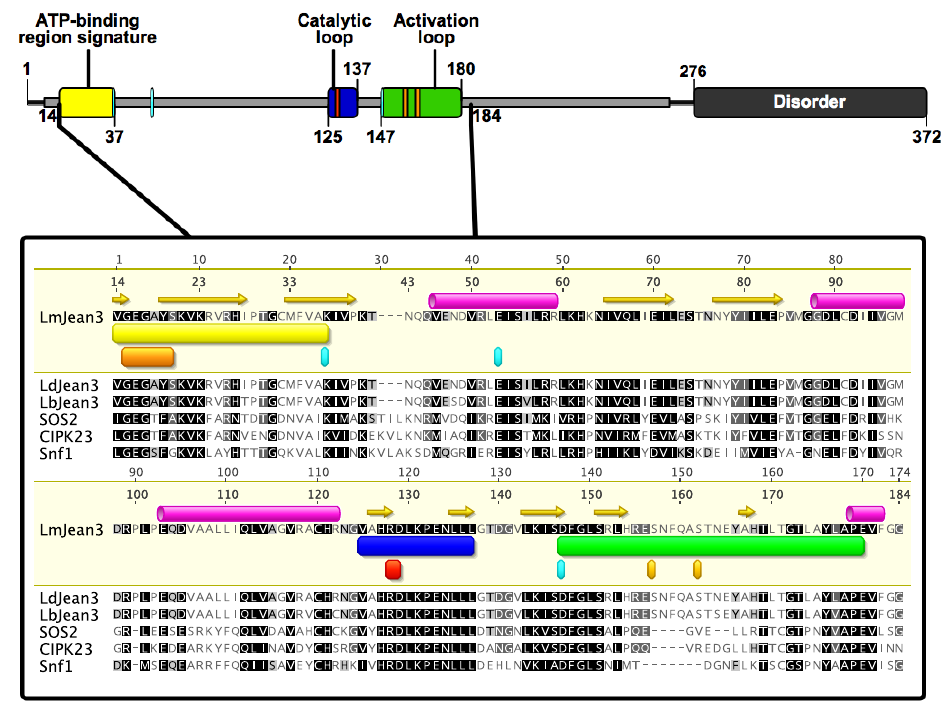
Figure 3. The kinase domain of LmJean3 homologues shares a high overall similarity to CIPK24 / SOS2, CIPK23, and Snf1 kinase domains. On top: schematic representation of LmJean3 secondary structure, sequence, and regions. Underneath: LmJean3 sequence alignment (residues 88-211) with Leishmania donovani Jean3 (LdJean3), L. braziliensis Jean3 (LbJean3), A. thaliana CIPK24 / SOS2, A. thaliana CIPK23, and S. cerevisiae Snf1. Within the ATP-binding region signature (yellow rectangle), the glycine-rich loop is highlighted as an orange rectangle (residues 15–20). The catalytic and activation loops are marked